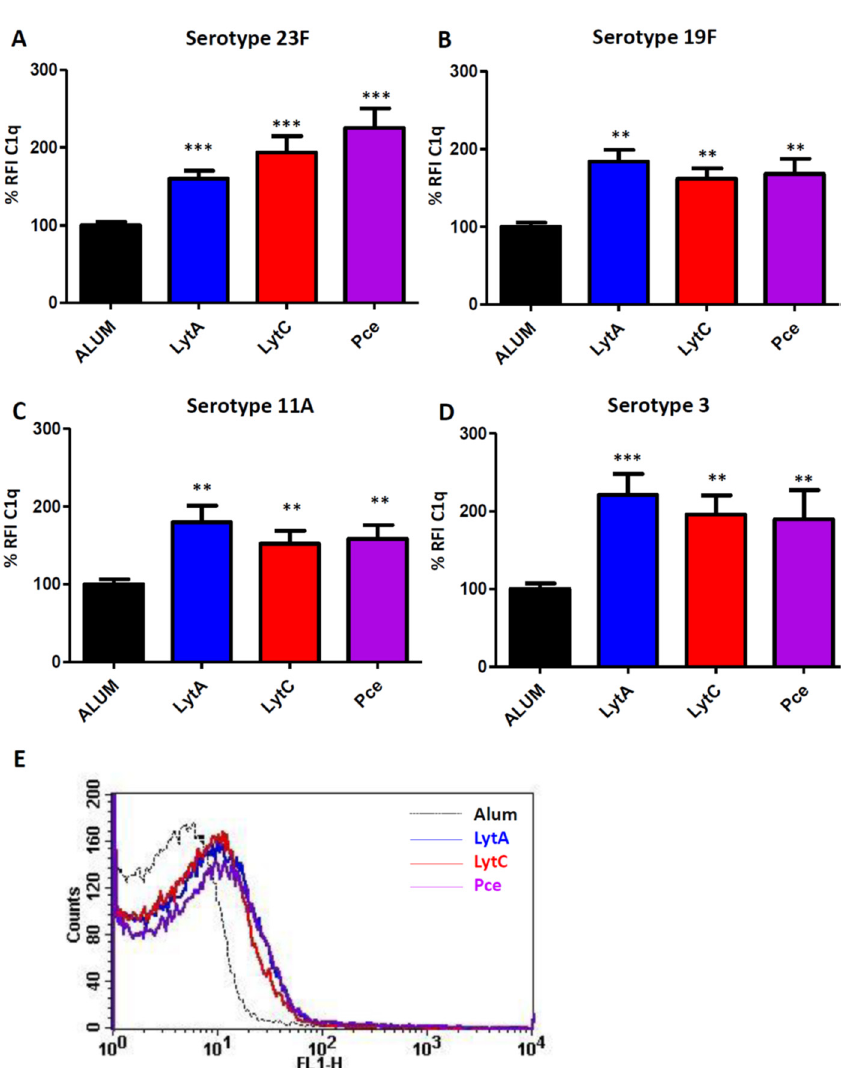
Figure 2. Classical pathway activation mediated by antibodies against LytA, LytC, or Pce. These assays measured deposition of mouse C1q on the surface of the corresponding bacterial strain using pooled sera from mice immunized with Alum (black bars) or with LytA-Alum (blue bars), LytC-Alum (red bars), or Pce-Alum (purple bars). ( A ) Strain 48 (serotype 23F). ( B ) Strain 69 (serotype 19F). ( C ) Strain 450 (serotype 11A). ( D ) Strain 957 (serotype 3). ( E ) Example of a flow cytometry histogram for C1q deposition on the serotype 23F strain. Results are expressed as a relative % fluorescence index (% RFI). Error bars represent the SDs and asterisks indicate statistical significance of LytA, LytC, or Pce immunization compared to the Alum group; ** p < 0.01; *** p < 0.001.